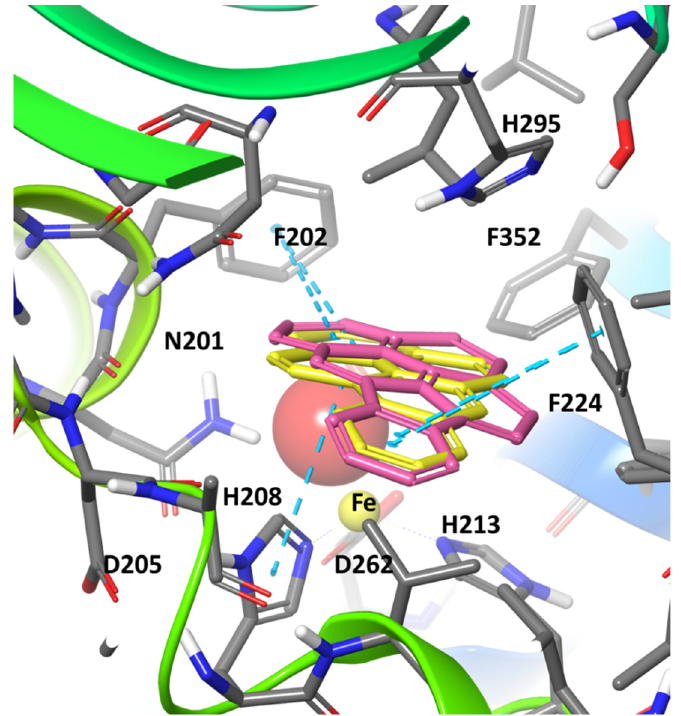
Figure 7. Molecular docking of benzo(a)pyrene (yellow) and indeno(1,2,3-cd)pyrene (salmon) into naphthalene dioxygenase from Pseudomonas sp. C18 (ID 4hjl), with docking scores of − 9.9 and − 9.0 kcal/mol, respectively. Dashed cyan lines indicate aromatic staking interaction in catalytic pocket (Phe224, Phe202, and H208). Red ball represents oxygen molecule. Fe interacts with His213, Asp362, and His208. Remaining binding site residues not shown to clarify the